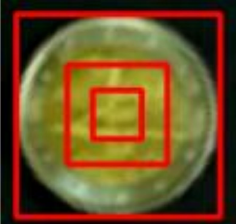
Figure 6. Coin identification